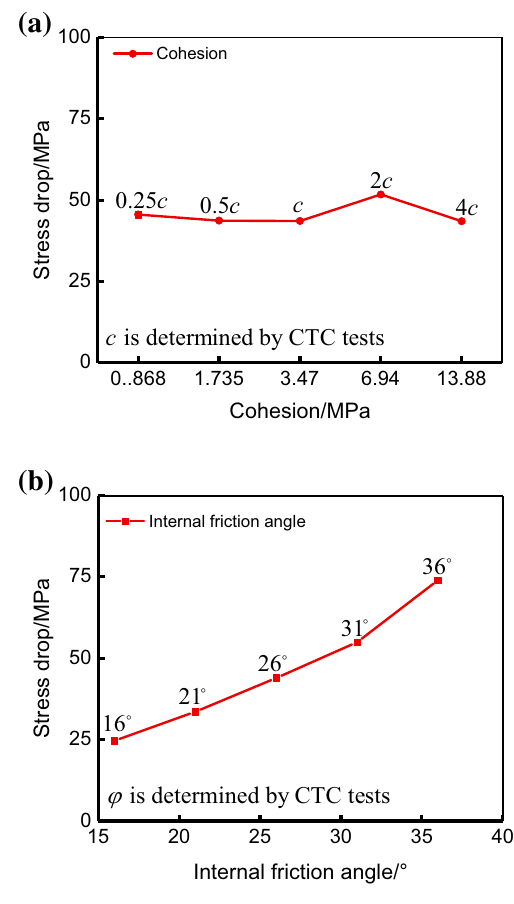
Fig. 8 Quantitative descriptions of stress drop by a cohesion and b internal friction